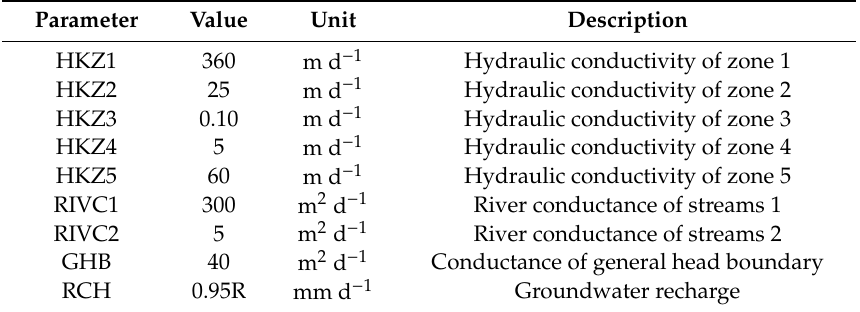
Table 1. Calibrated parameters for the calibrated model. R represents the spatial distribution map of average groundwater recharge.